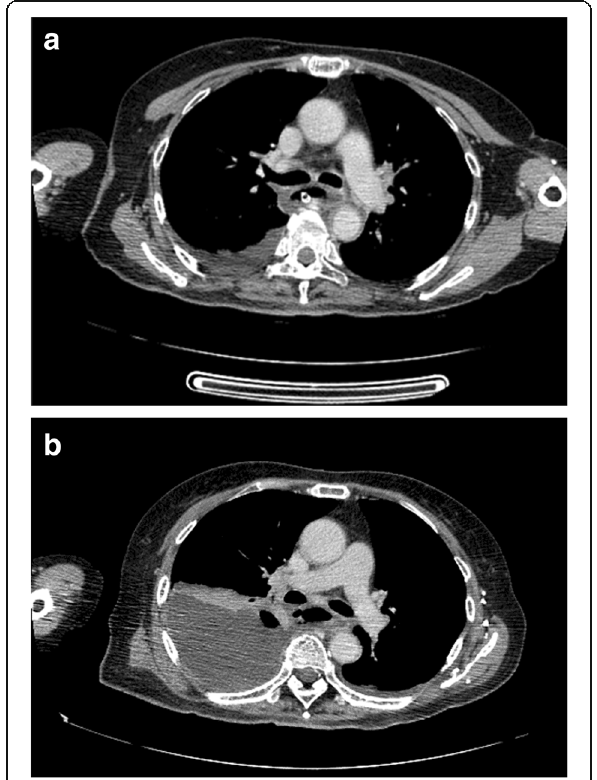
Fig. 2 CT scan on admission day and on the 7th day after admission. a Circumferential edematous thickening of the esophageal wall with slight pleural effusion. b CT scan showed a significant increase of the right pleural effusion and free air in the mediastinum